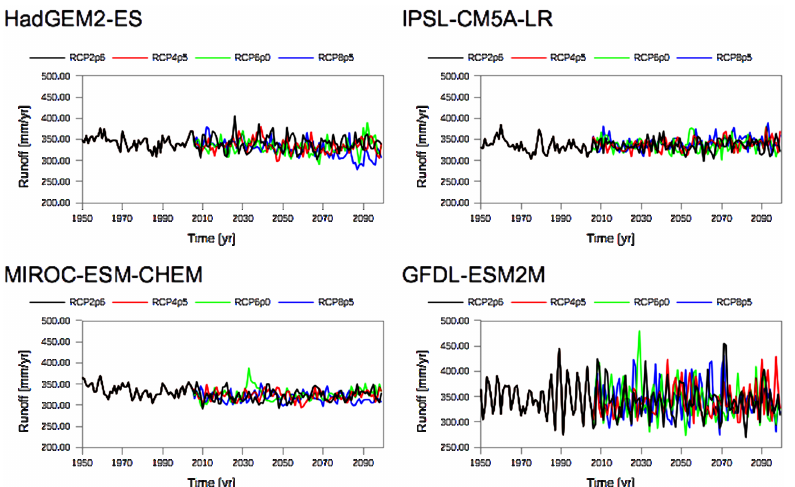
Figure 2. Global continental runoff estimates based on bias corrected present and projected future climate conditions using the ISI-MIP forcing data.